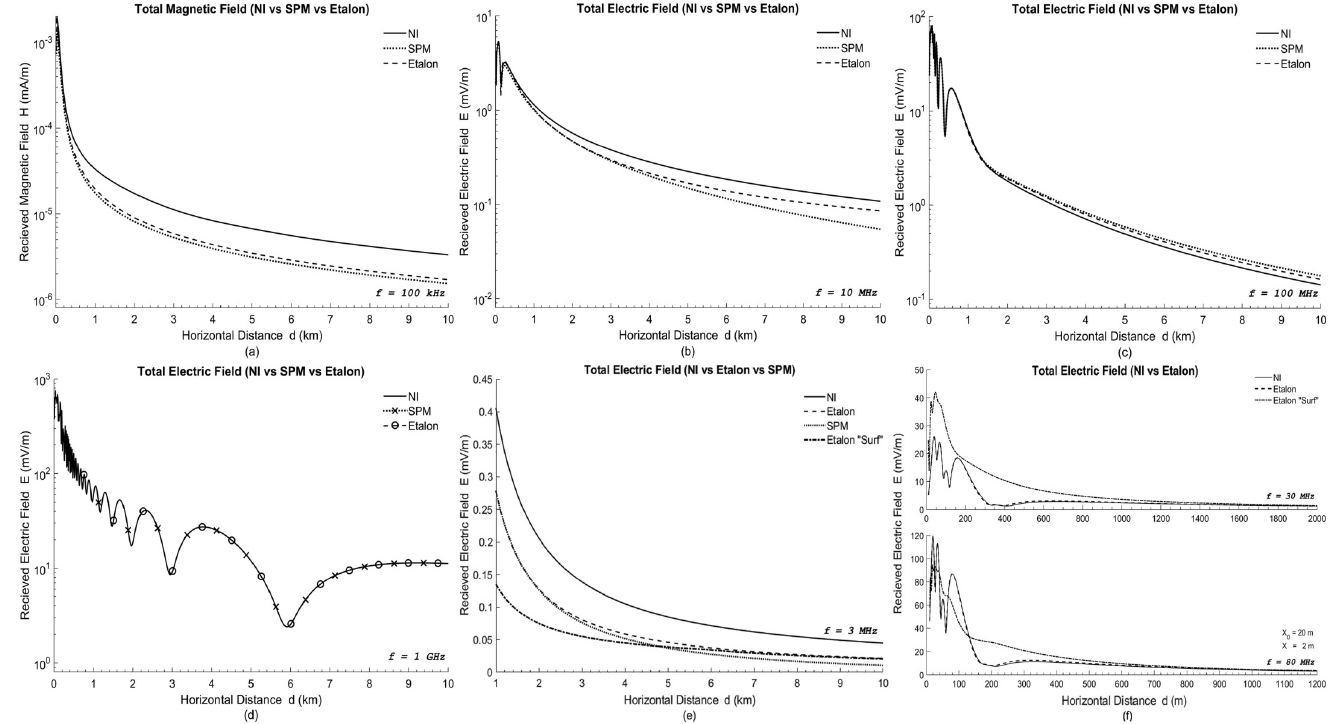
Figure 9. EM field magnitude over horizontal distance ( d ) for various distinct frequencies ( f ), as indicated within each sub-figure ( a – f ). The term Etalon “Surf” refers to the evaluation of (26). Figure 9a, exhibits the magnetic field. The rest of the labeling convention of Figure 8